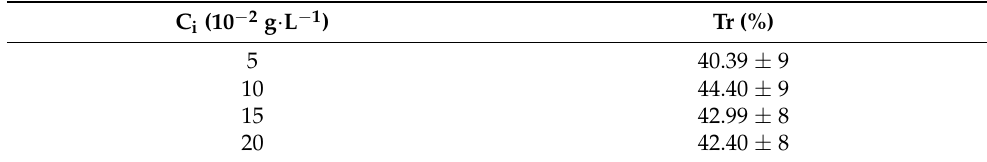
. γ , the shear rate (s − 1 ). The